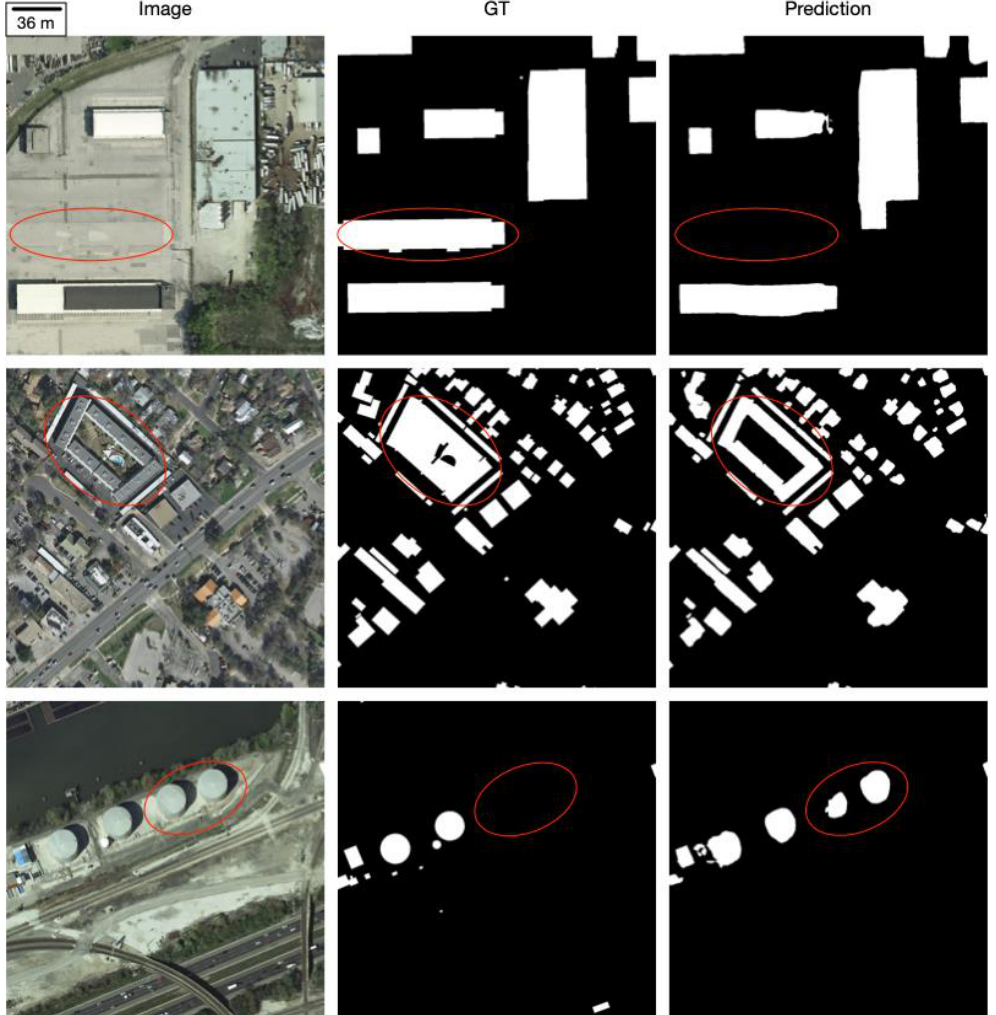
Figure 11. Examples of some mismatched ground truth labels on Inria Aerial Image Labelling Dataset, mislabelled areas are annotated by the red circles.